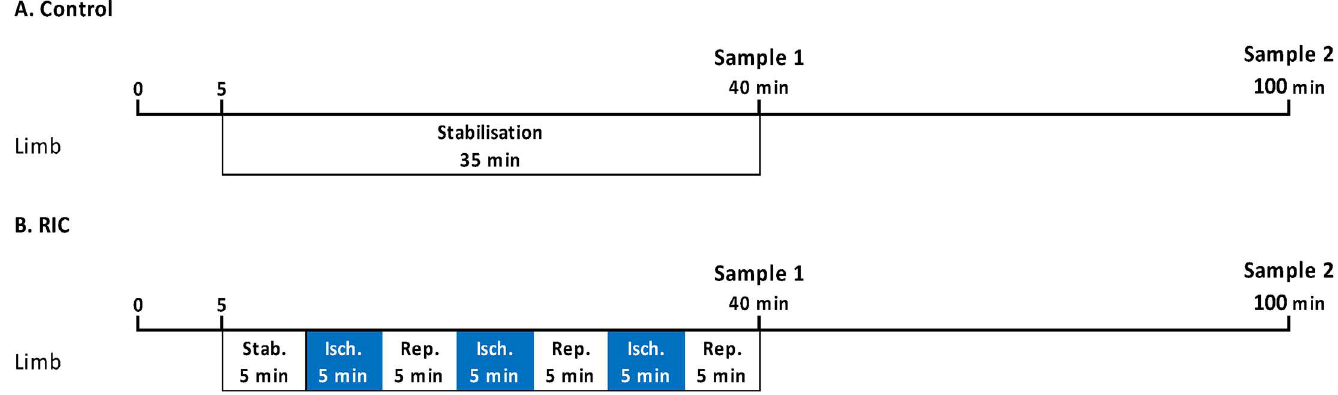
Fig 3. In vivo rat protocols. Remote ischaemic conditioning (RIC) was appliedto the rat hind limb in the followinggroups: A) Control: 35 min stabilisation; B) RIC: 5 min stabilisation, 3 cycles of 5 min ischemiaand 5 min reperfusion.Blood samples were taken either immediately after RIC (sample1) or 60 min thereafter (sample